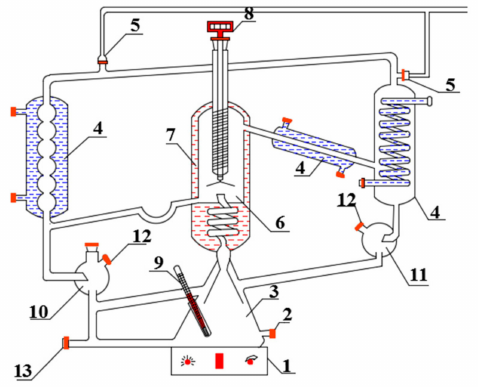
Figure 1. Vapor–liquid equilibrium instrument.